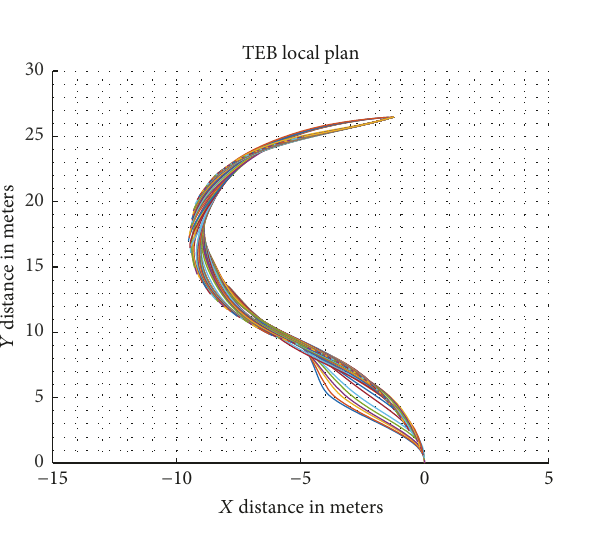
Figure 13: Odometry points.